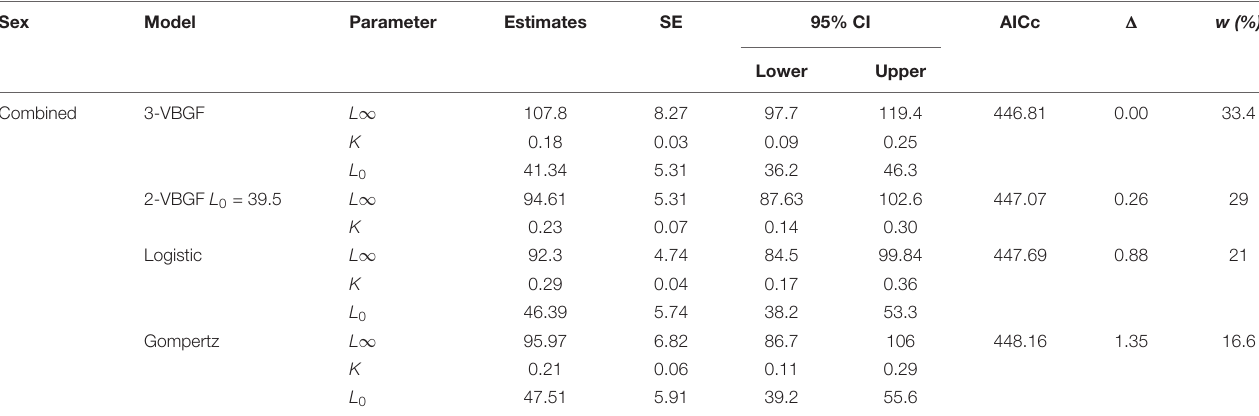
TABLE 3 | Growth parameters estimated for P. kamoharai (combined sexes) in the TEA from four growth models fitted to length-at-age data. Sex Model Parameter Estimates